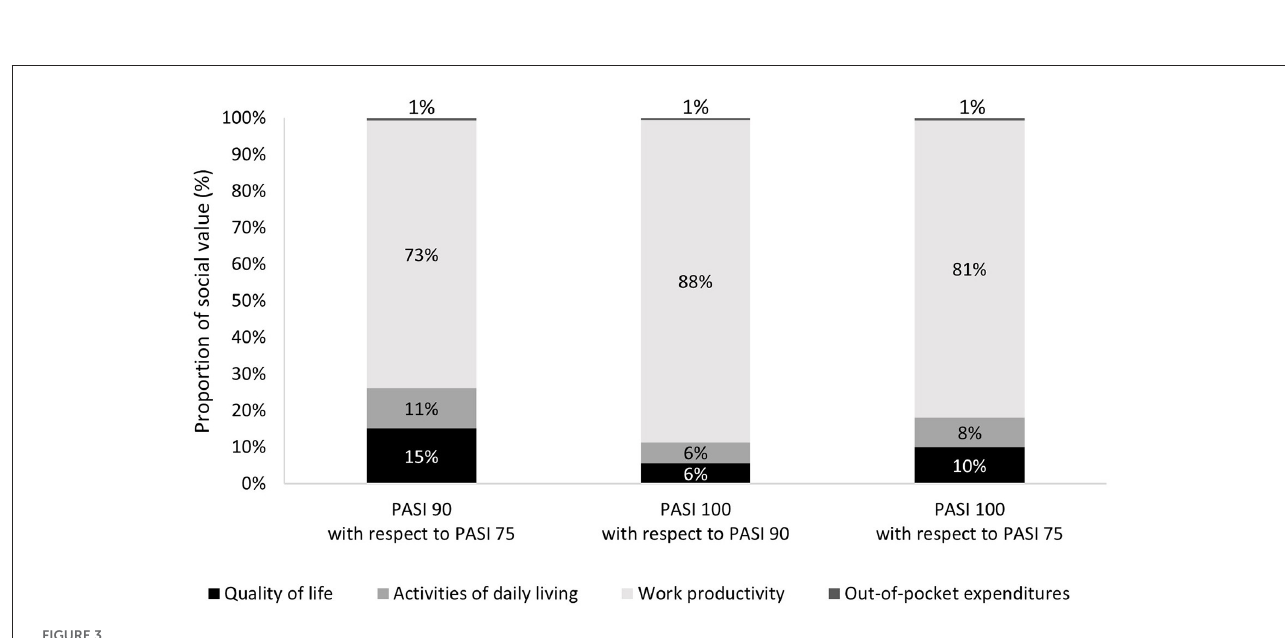
FIGURE3 Distribution of social value according to areas of analysis and PASI scenarios.